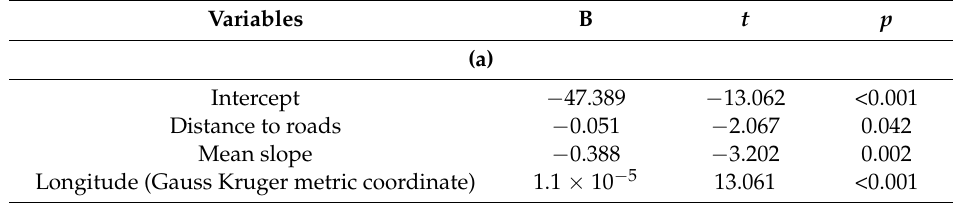
Table 4. Linear combination of the variables that were selected ( p ≤ 0.05) through a forward multiple regression procedure to explain ( a ) PCA axis 1, ( b ) PCA axis 2, and ( c ) conversion rate into